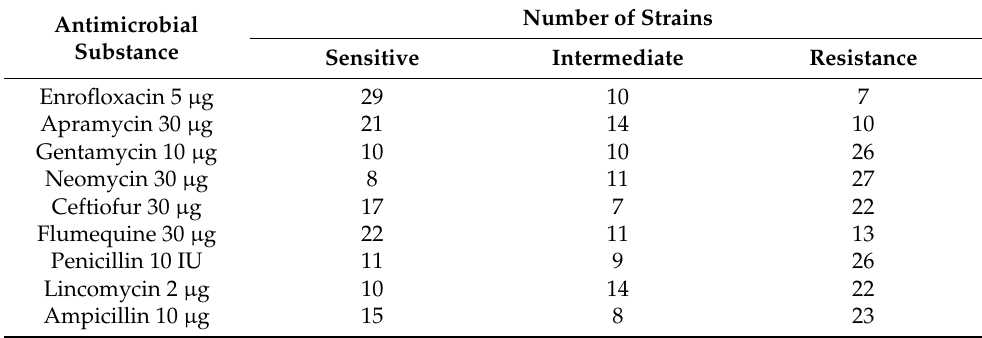
Table 2. Behavior of isolated gram-negative bacterial strains in antimicrobial substances. Number of Strains Antimicrobial Substance Sensitive Intermediate